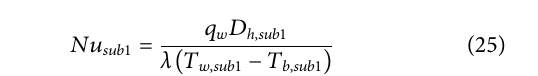
Frontiers in Energy Research |